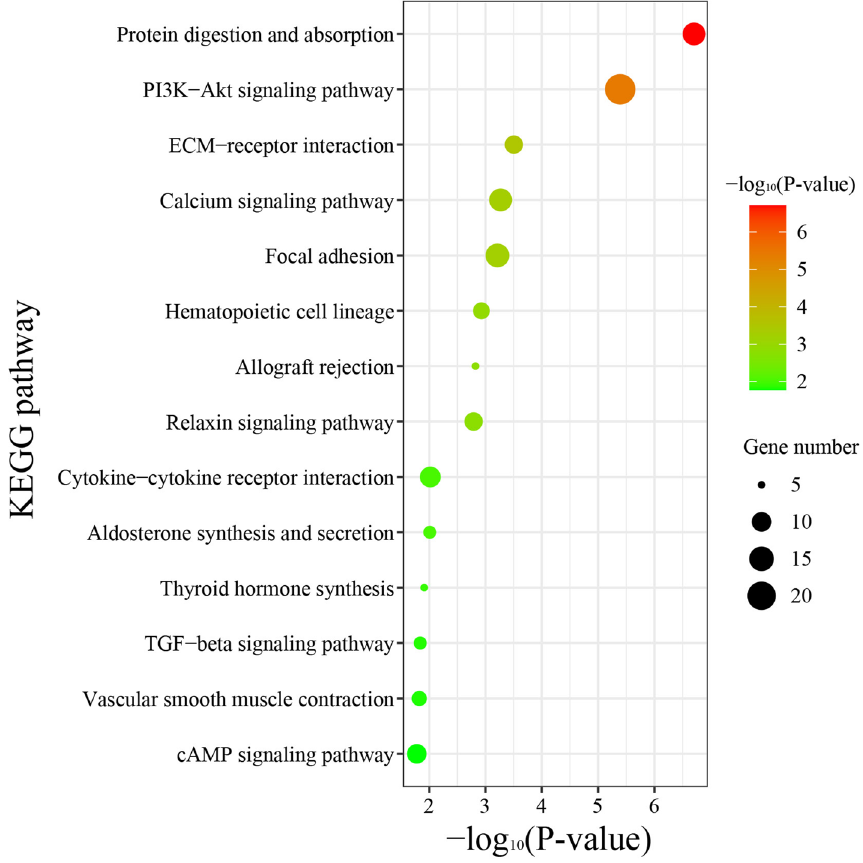
Figure 7. KEGG pathway analysis of the diferentially expressed genes (DEGs) between the large knob (L) and small knob (S) groups. The X-axis represents the larger the − log 10 P value is, the more significant of enrichment of the DEGs in this pathway is. The Y-axis represents the name of pathway. The size and color of each bubble represent the amount of DEGs enriched in the pathway and enrichment signifcance, respectively (P adjust <